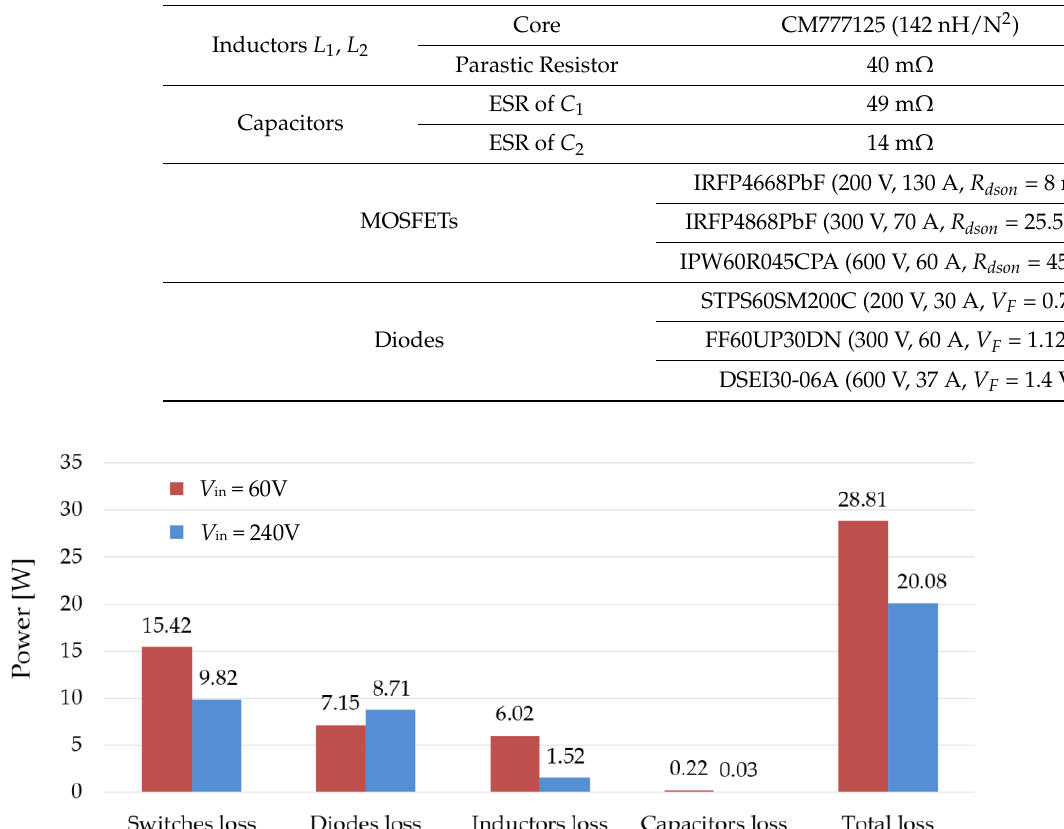
Figure 11. Power loss distribution of the proposed CGBBI.